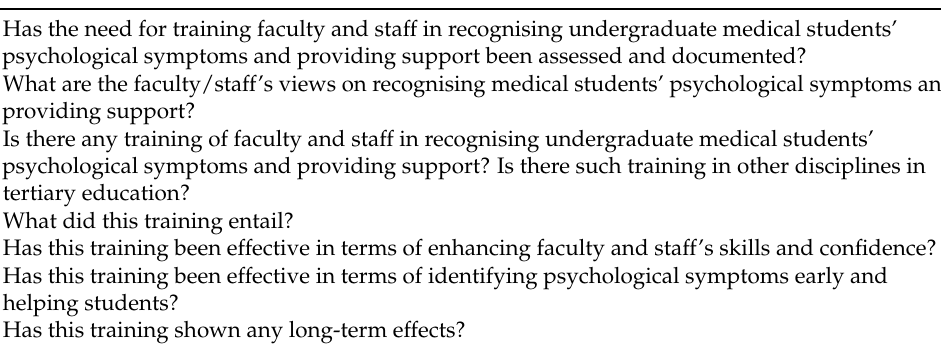
Table 2. Questions for facilitating search